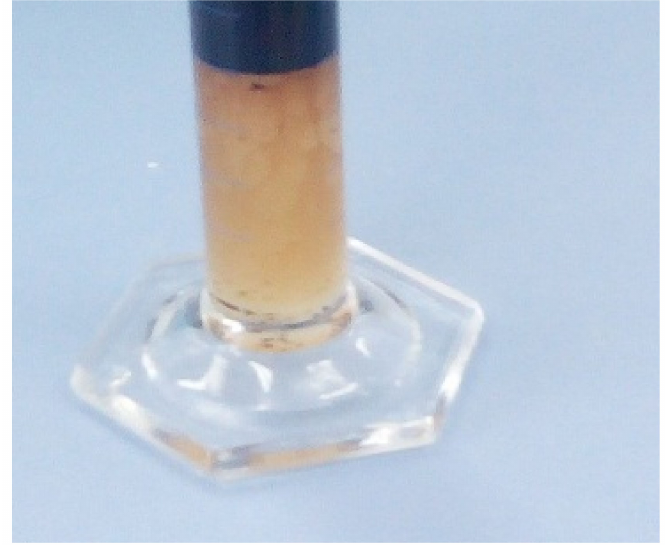
Figure 24. Microemulsion